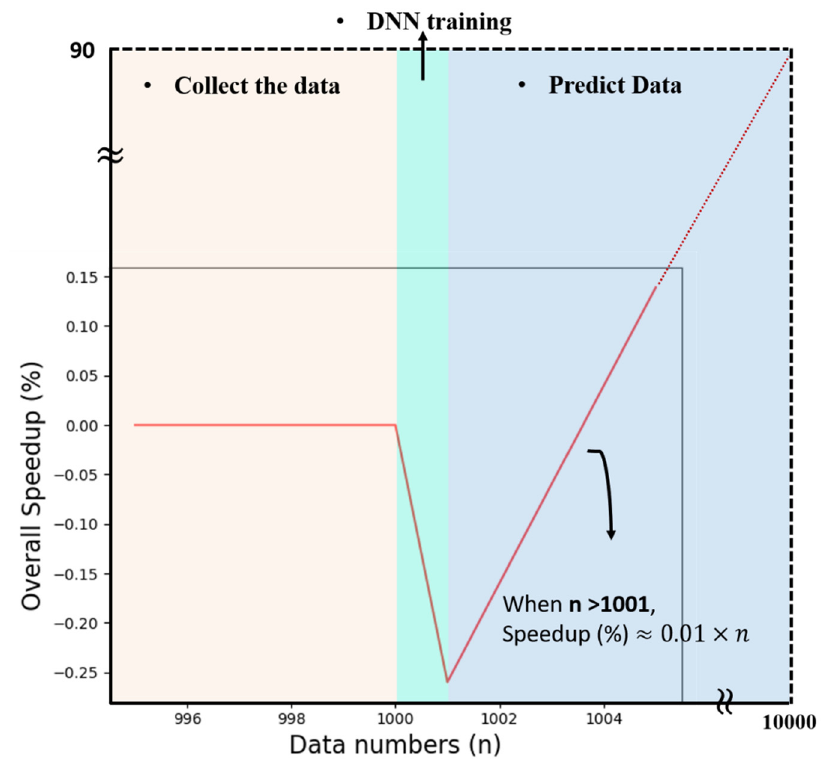
Figure 7. Overall speedup for the proposed method combining the FDTD method and DNN model. The horizontal axis is data numbers. The vertical axis is overall speedup.